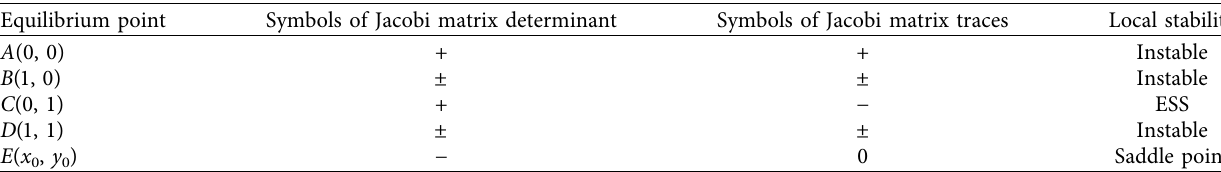
Table 6: Local stability analysis of equilibrium